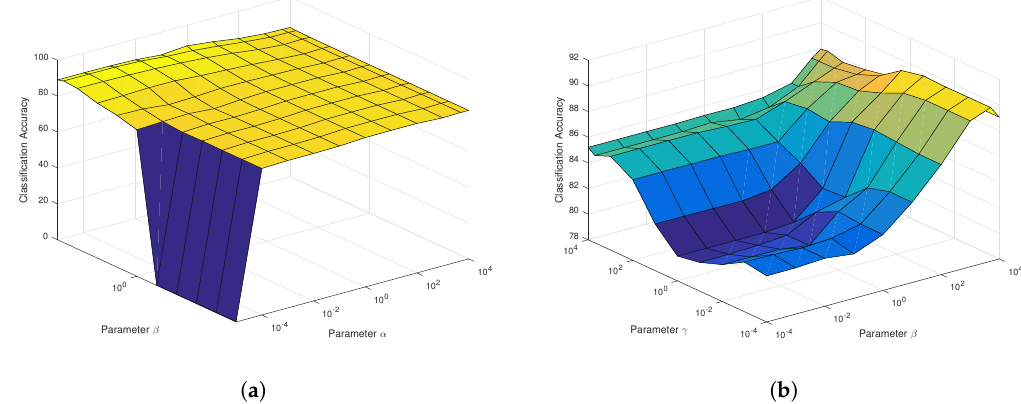
Figure 10. Classification accuracy (OA) w.r.t. different regularization parameters on the Indian Pines data: ( a ) parameter sensitivity analysis for regularization parameters α , β in SaCGDA; ( b ) parameter sensitivity analysis for regularization parameters β , γ in LapSaCGDA.